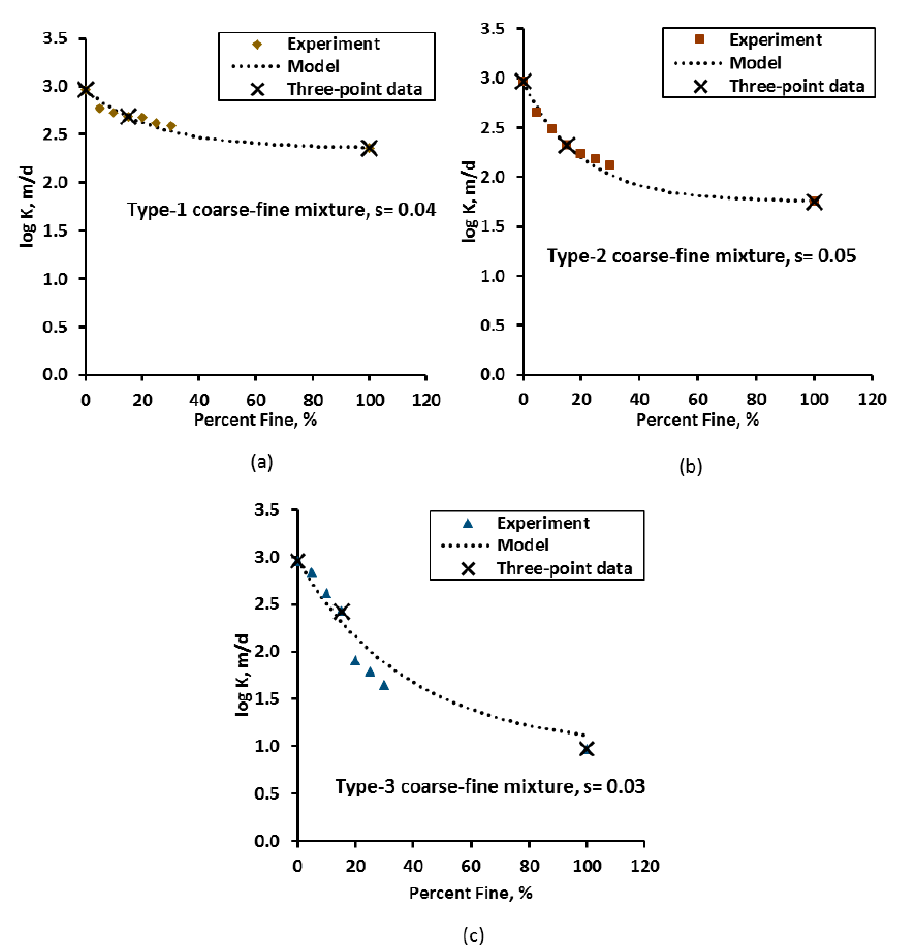
Figure 3. Comparison of fitted model results with experimental data for all three types of coarse-fine mixtures: ( a ) Type-1 (K c = 920 m/day and K f = 228 m/day), ( b ) Type-2 (K c = 920 m/day and K f = 57 m/day), and ( c ) Type-3 (K c = 920 m/day and K f = 9 m/day). The effective hydraulic conductivity K values are plotted on y axis in log scale. The cross symbol is used to identify the data points used in the three-point method discussed in Section 3.5.